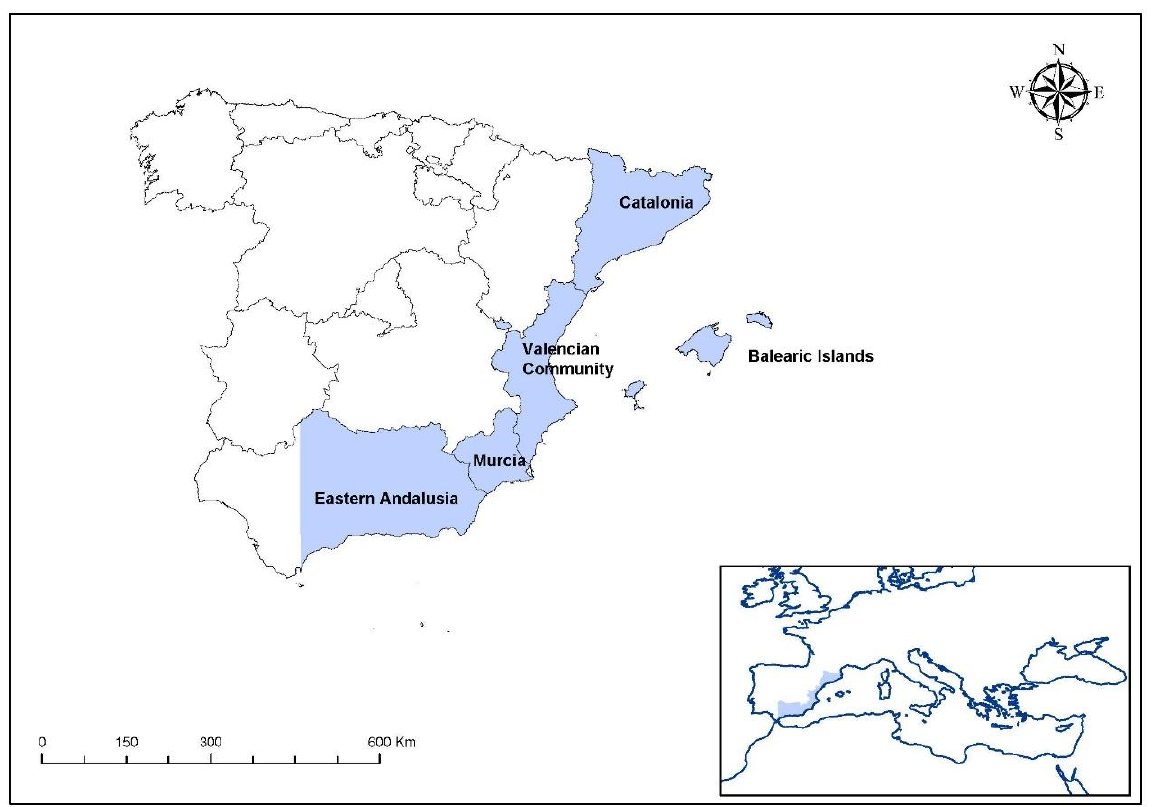
Figure 1. MAP 1 Study area .